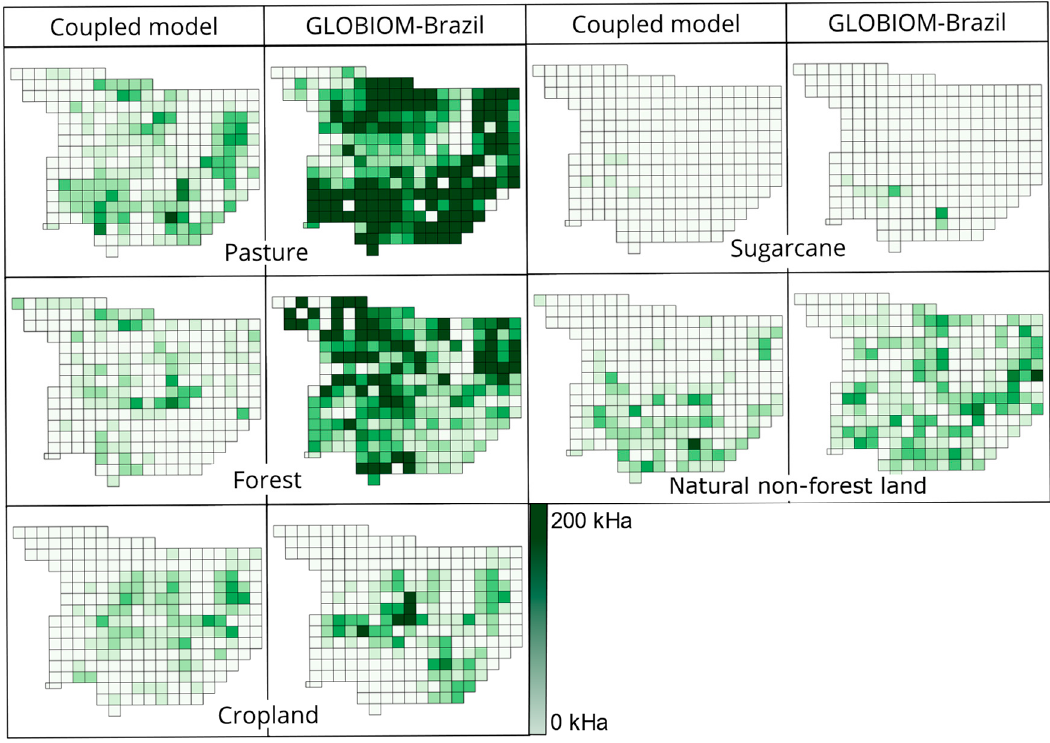
Figure 6. Differences between LUC projected by the models and LUC in the observational data [21,27] for Mato Grosso for 2007–2015. The darker colors indicate larger differences, i.e., higher model errors.